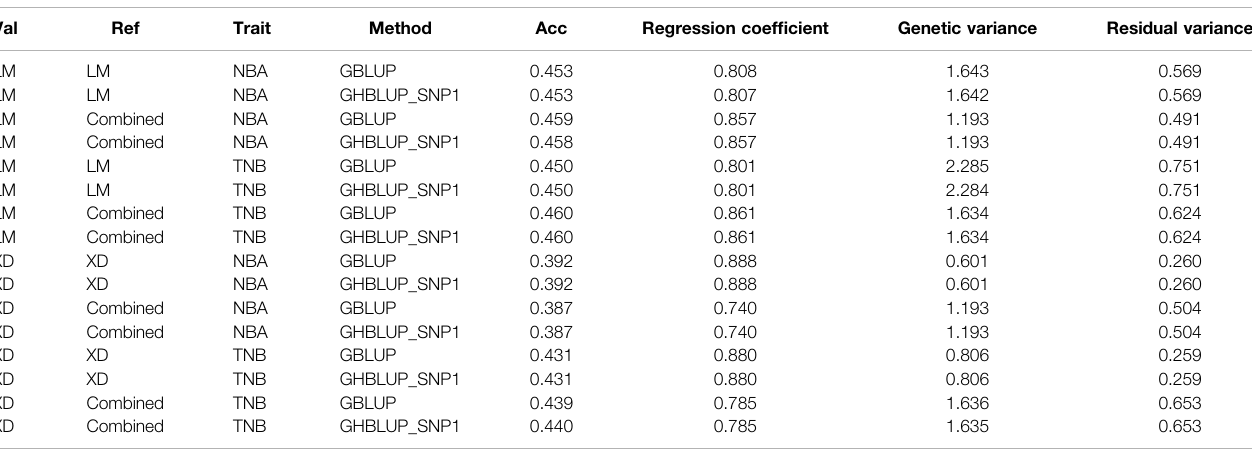
TABLE 2 | The comparison of prediction performance of the two